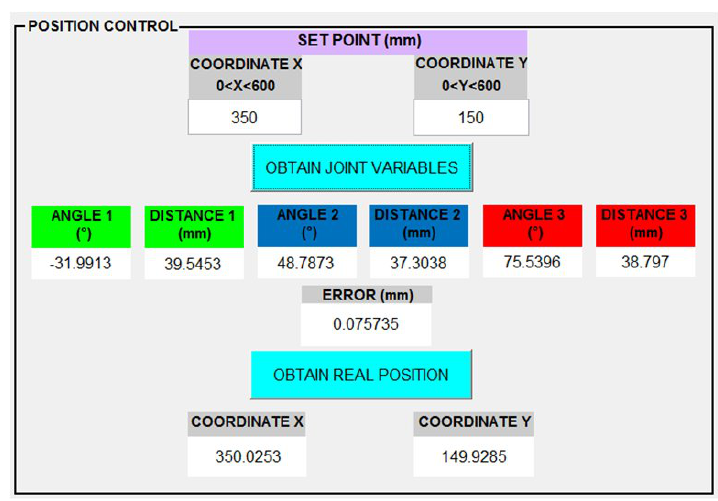
Figure 11. GUIDE window for obtaining the values of the joint variables.